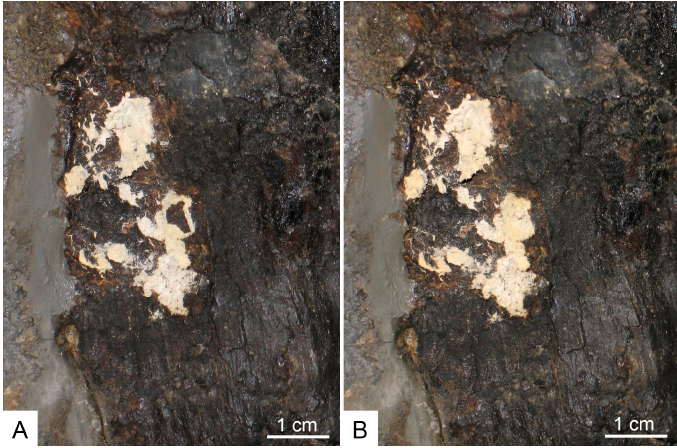
Figure 12. Evolution of efflorescence due to pyrite decay in the Latanites sp. palm in ( A ) November 2016; ( B ) March 2017.